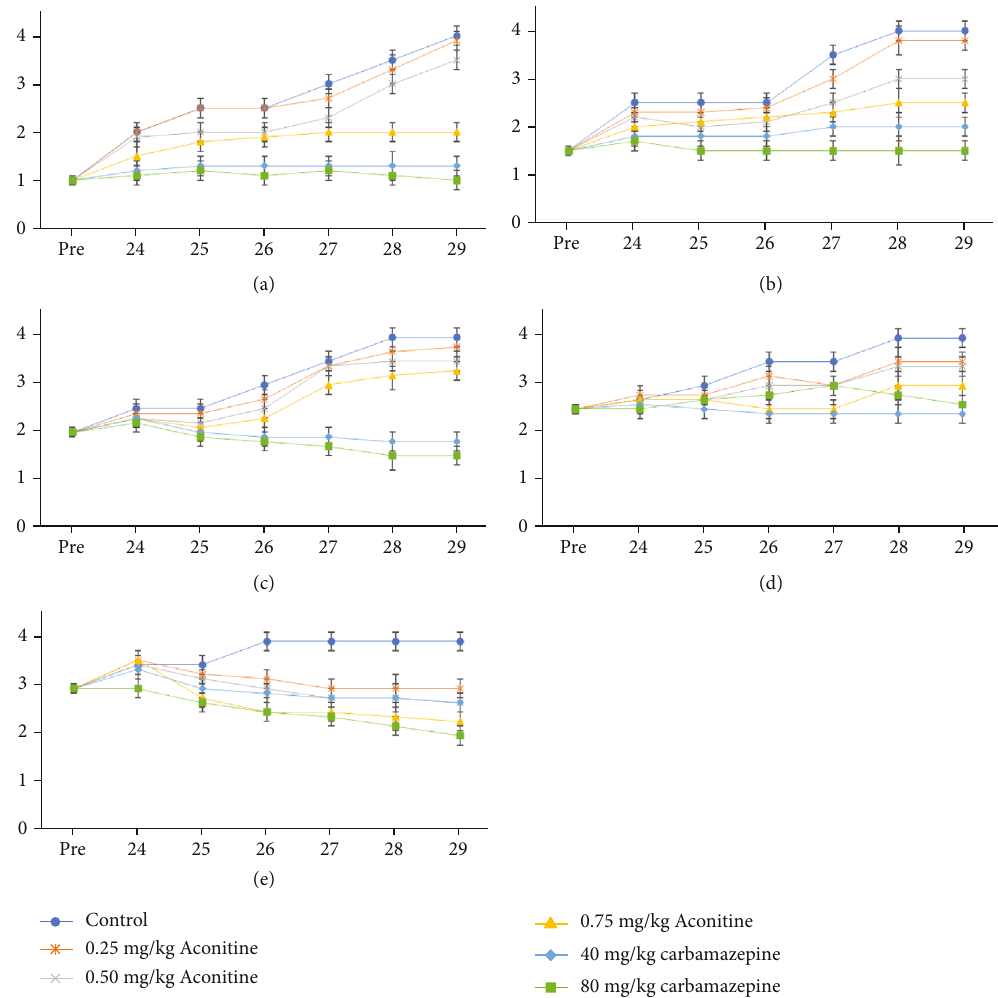
Figure 2: Response levels given to contralateral stimulations in behavioral tests with von Frey fi laments with (a) 0.015, (b) 0.127, (c) 0.217, (d) 0.745, and (e) 2.150g bond strength ( x axis represents days, y axis represents score).